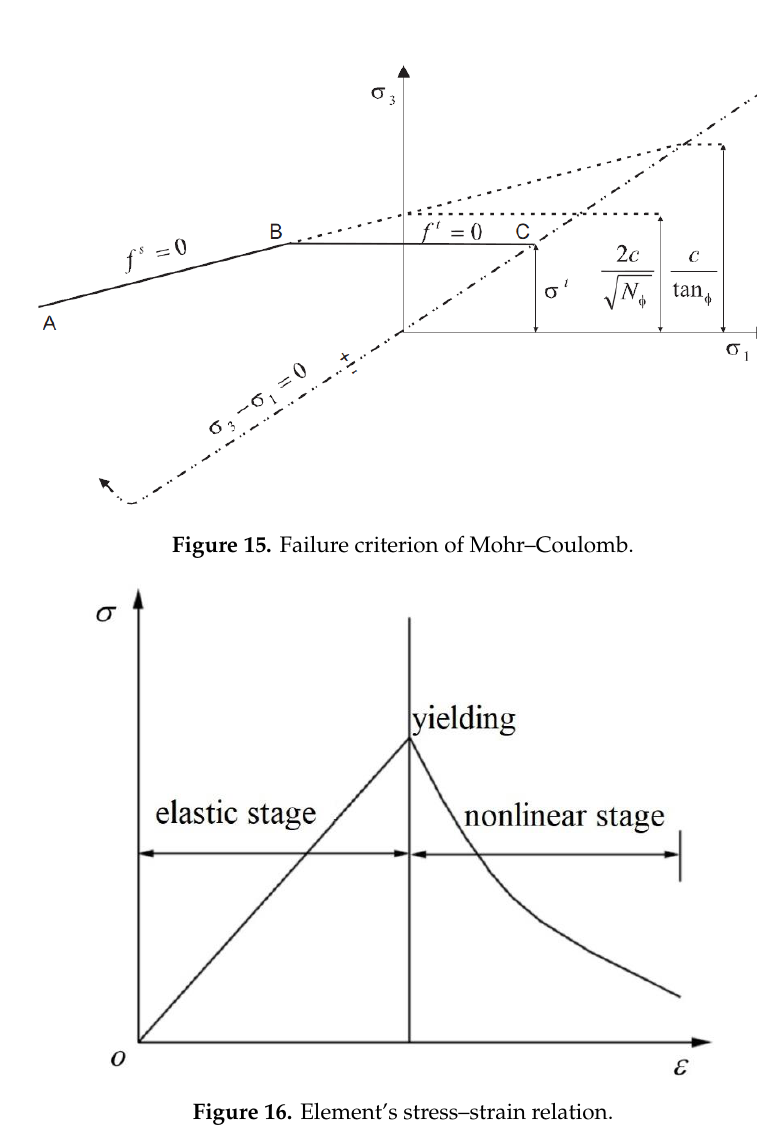
Figure 17. Numerical model of the initial support. 4.2.3. Simulation Results In order to highlight the effect of the new support scheme, a comparative test was carried out to simulate the deformation of a roadway without support.